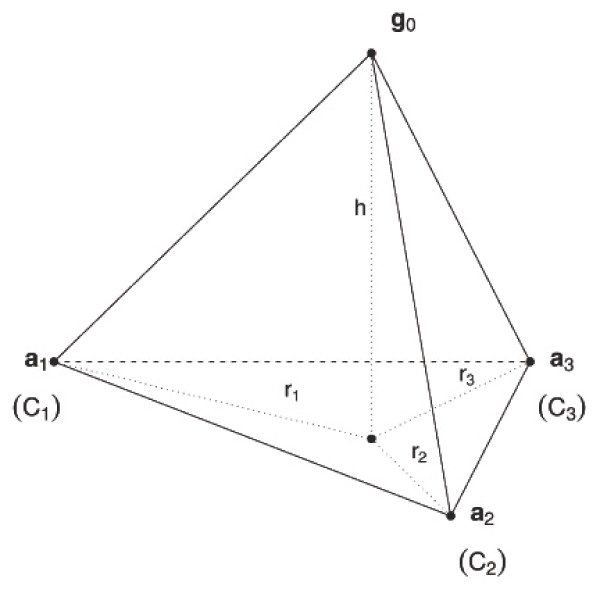
Geometrical interpretation of the INCA statistics. For k = 3, new observation {g0}, centers of clusters {a1, a2, a3} and (squared) projection ri of the edges {g0, ai} on the plane {a1, a2, a3}. The (squared) height h is the INCA statistic.